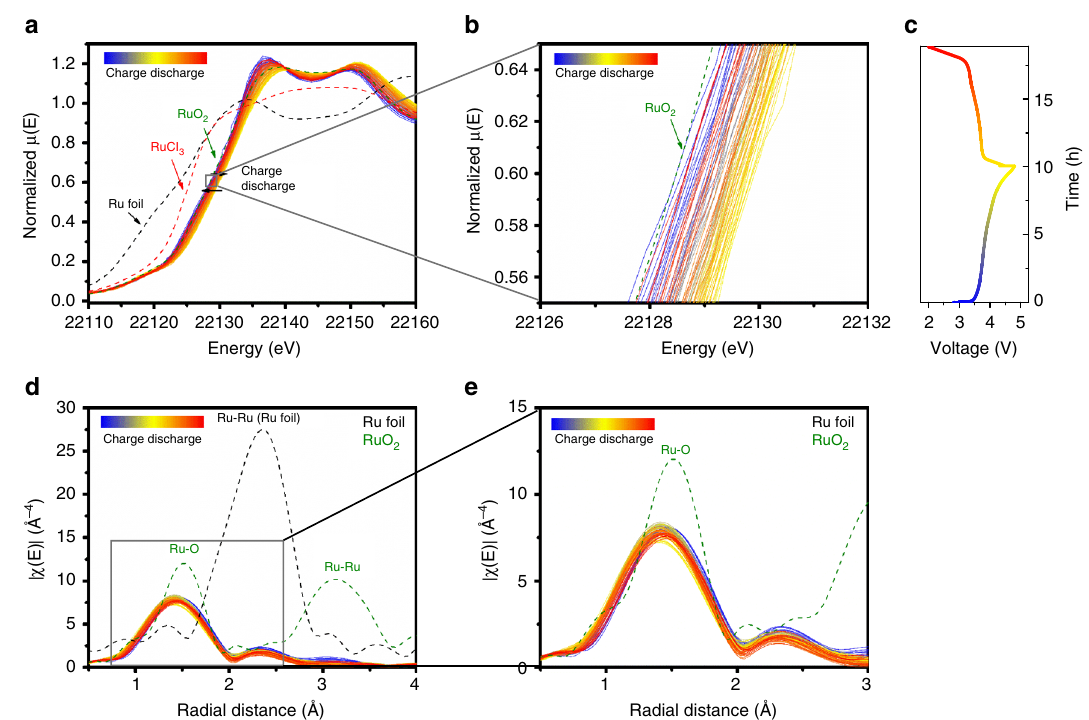
Fig. 6 Electronic structure of Ru as probed by in situ XAS. In situ a , b XANES, c voltage pro fi le, d , e EXAFS of Ru K-edge of LNRO during the fi rst cycle. The in situ cell was charged at C/10 and discharged at